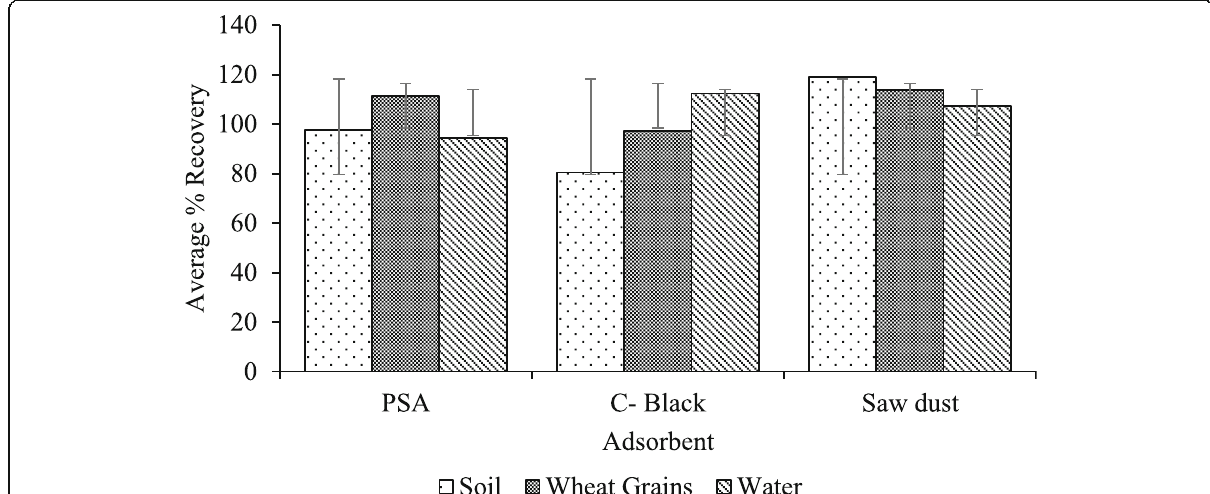
Fig. 2 Comparison of the cleanup sorbents used in modified QuEChERS approach for extraction of PXD: spiking level 0.5 μ g/g. Error bars signify standard error ( n = 3)